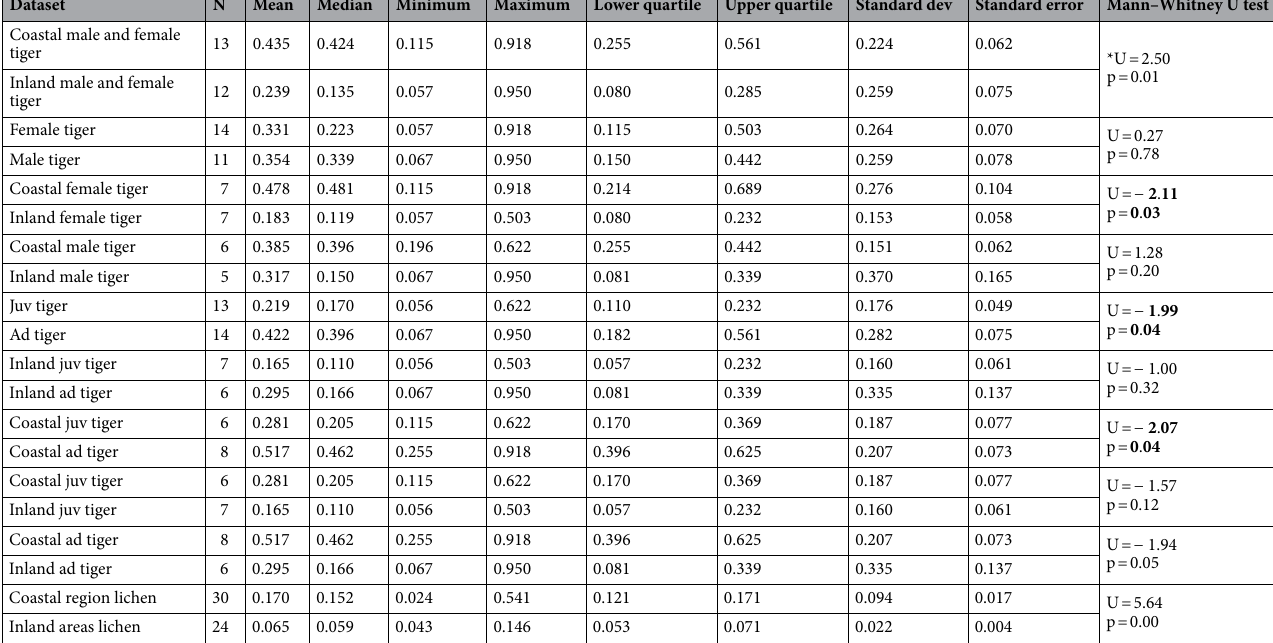
Table 1. Statistics on the subsets of THg concentration data used in this paper. All concentrations are in mg kg −1 . *Except for four samples with unknown gender. Statistically significant differences are given in